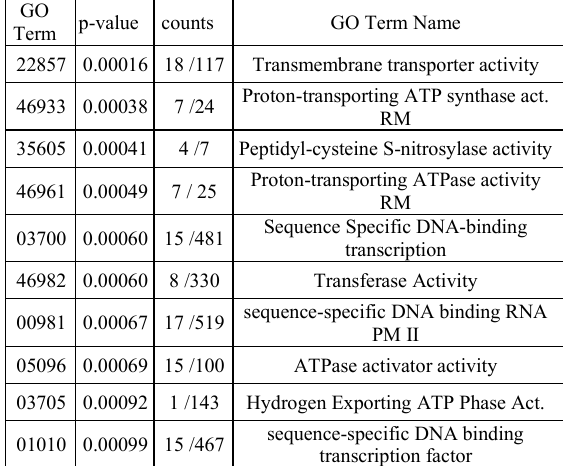
Figure 8. P-values of up and down regulated genes Based on highest count value P-value is calculated. Then select the gene ontology terms relevant to specific molecular function thus forming a sub-ontology which includes a set of ancestors to the corresponding terms. The level of significance of p-values is shown in Figure 9 . The nodes Figure 7. Testing significance by (1) Cubic polynomial having shade closest to blue are the least significant fit and (2) p-value vs q-value ones and the nodes having shade red are the most significant ones. Table 3. P-values of annotated GO terms